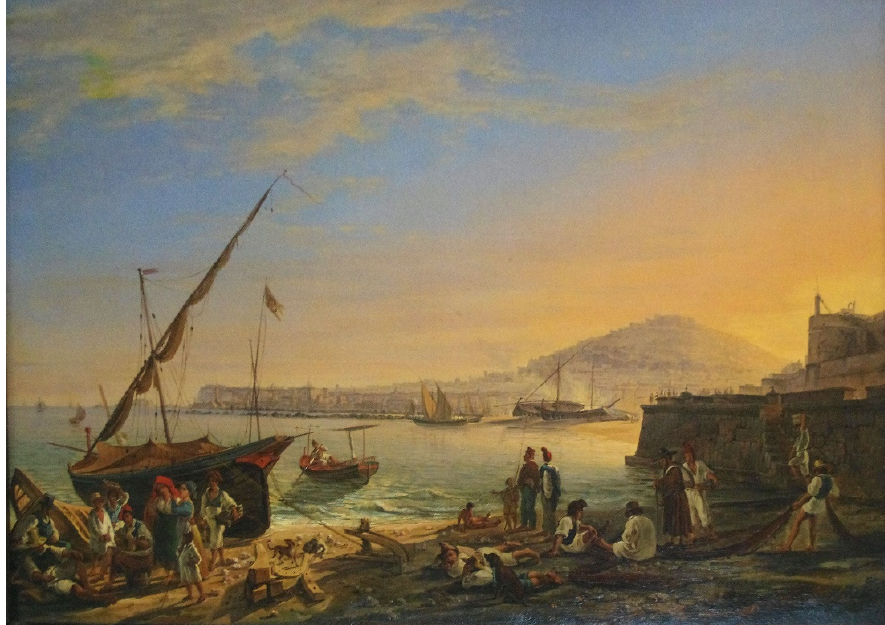
Figure 22. Sylvester Shchedrin. A View of Naples , 1820. Kramskoi Voronezh Regional Museum of Art.